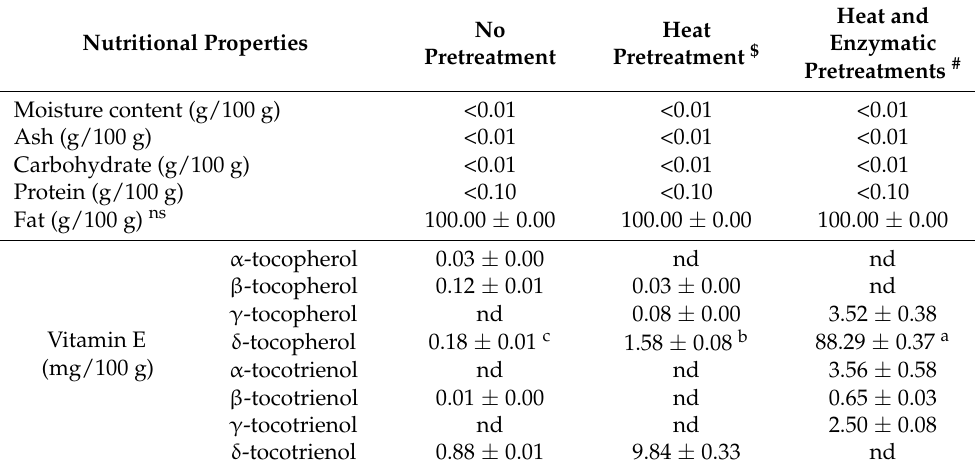
Table 6. Nutritional properties of H. heteroclita seed oils under different extraction pretreatment conditions.